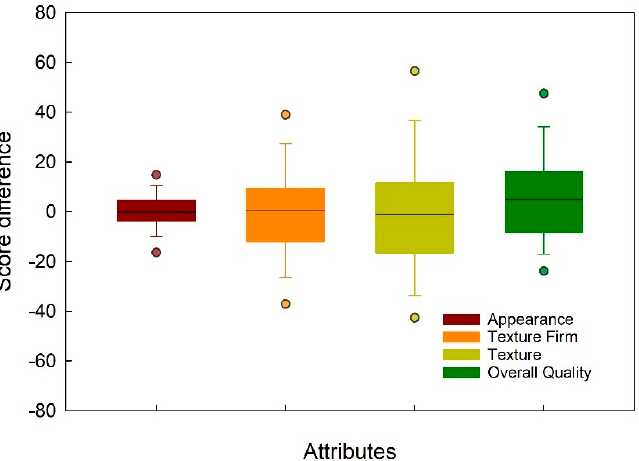
Figure 2. Boxplots generated from score differences between those for images and for real produce, combining data means across all commodities: (i) Appearance (IA-A), (ii) Texture Firm (IT-TF), (iii) Texture (IT-T), (iv) Overall Quality (IO-O). The dots represent outliers.